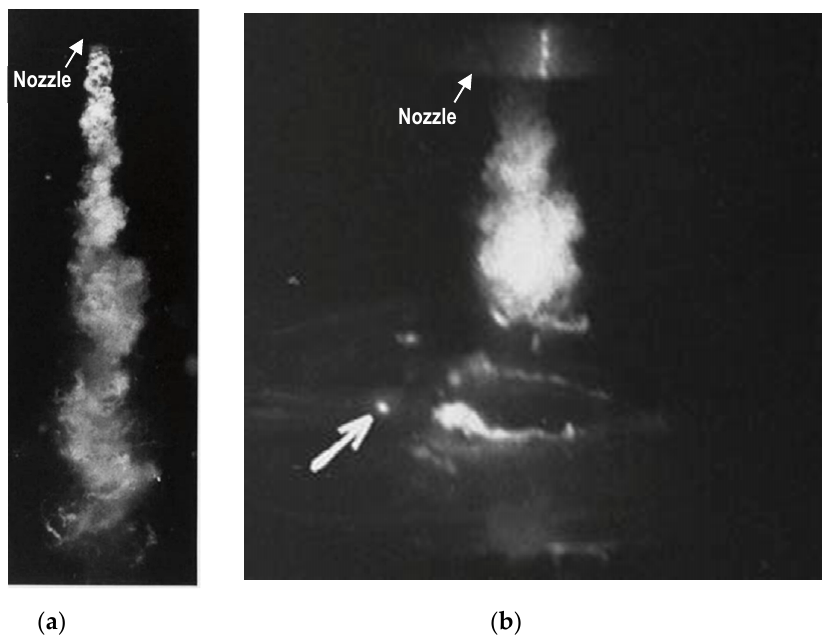
Figure 5. Vortex cavitation in cavitating jet: ( a ) helical vortex cavitation in free cavitating jet (conical nozzle, nozzle diameter d = 2.1 mm, upstream pressure p 1 = 6 MPa, downstream pressure p 2 = 0.18 MPa); ( b ) ring vortex cavitation on impinging surface (cylindrical nozzle, nozzle diameter d = 2 mm, upstream pressure p 1 = 12 MPa, downstream pressure p 2 = 0.36 MPa, standoff distance s = 40 mm) [9].